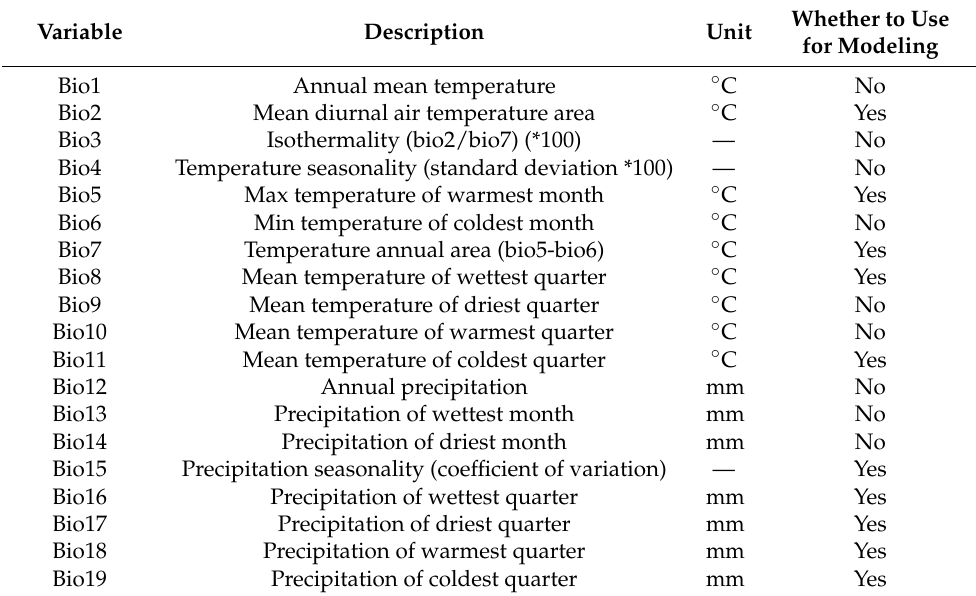
Whether to Use for Modeling